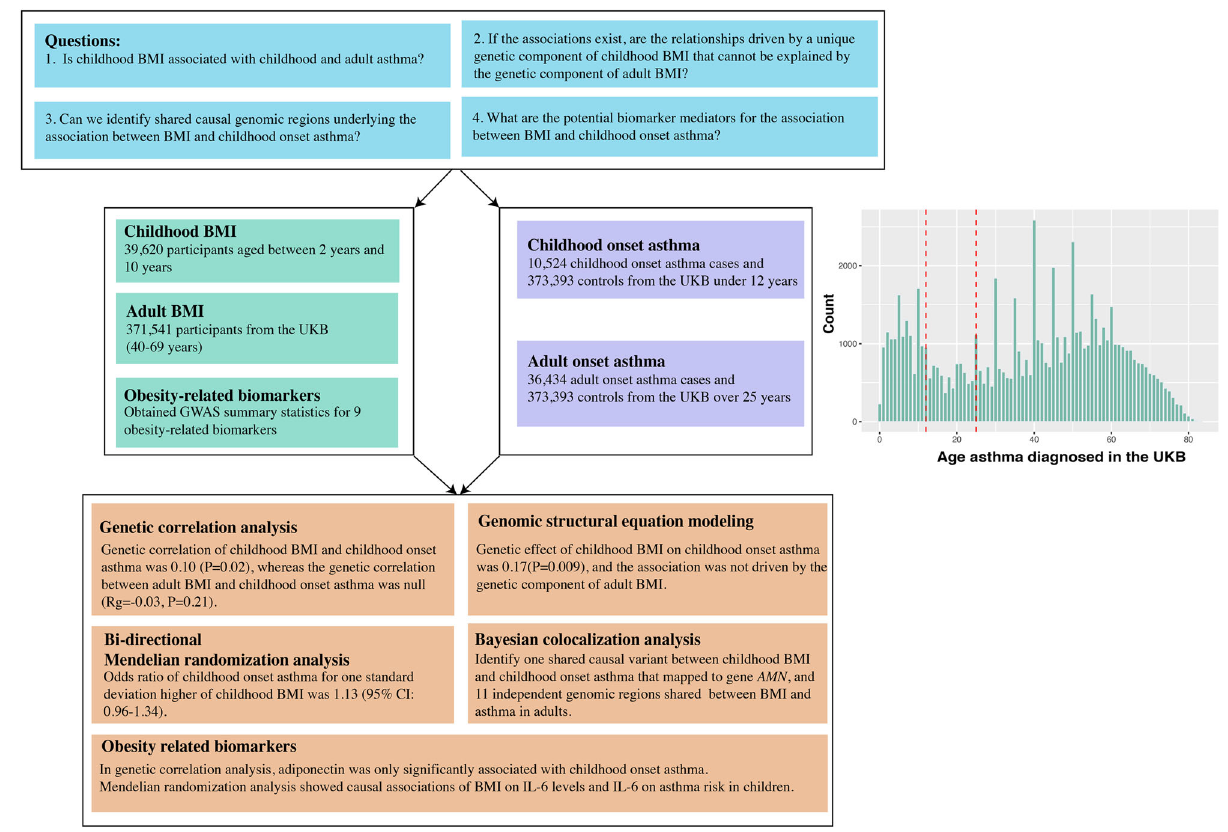
Fig. 1 Study summary fl